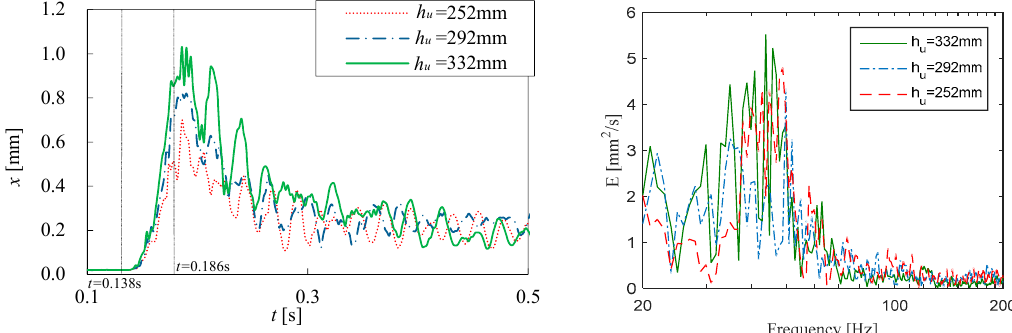
Figure 7. Horizontal displacement at the top of the structure under different water column height.